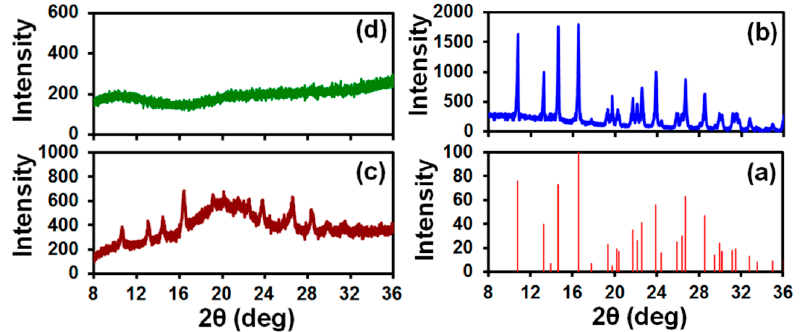
Figure 6. X-ray diffractograms: ( a ) griseofulvin reference pattern in the instrument library; ( b ) as-received griseofulvin powder (4.5 mg); ( c ) 20-mg porous HPMC film with 50 printed 0.5-µL droplets of 2.5% HPMC-griseofulvin suspension (calculated griseofulvin content 4.51 mg); ( d ) porous HPMC film (20 mg) without the suspension.